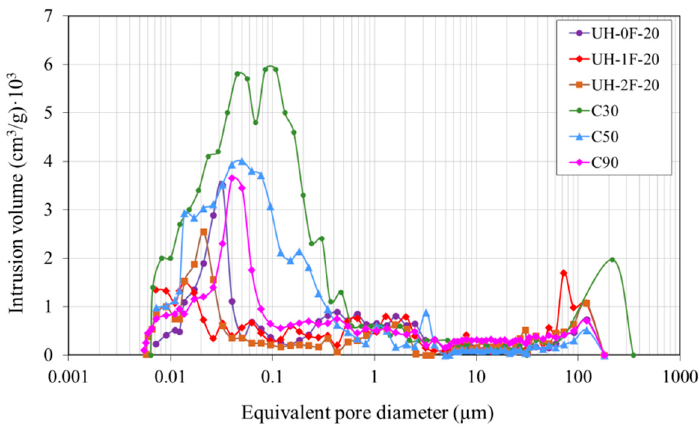
Figure 12. Pore size distribution.